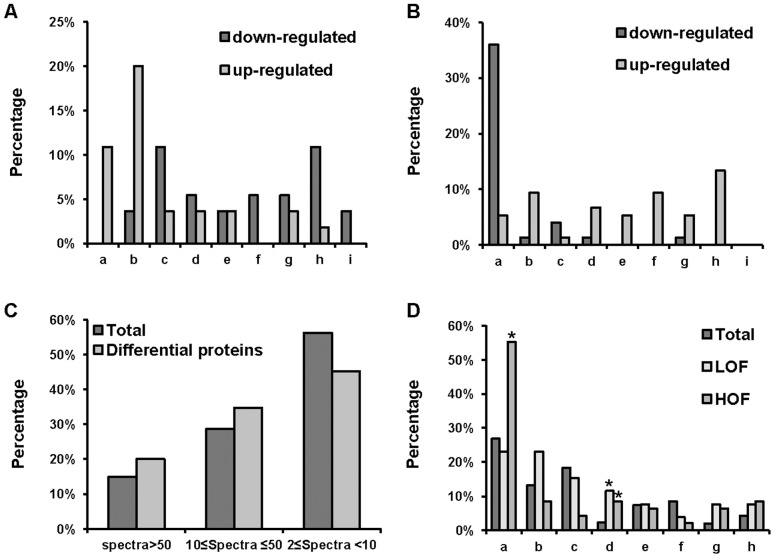
Functional category and protein abundance distribution analyses.(A and B) The distribution of proteins with differential expression in LOF or HOF across functional categories. The proteins were categorized in 9 groups as follows: a, Respiratory chain complex proteins; b, Membrane-associated proteins and transporters; c, Carbohydrate/lipid metabolism; d, calcium regulation-related; e, Peptide or amino acid synthesis/metabolism; f, Oxidation-sensitive; g, Chaperones; h, Translation-related; and i, Detoxification-related. Black bars: down-regulated proteins; gray bars: up-regulated proteins. (C) The abundance distributions of all mitochondrial proteins identified and the differentially expressed proteins. The protein abundance was categorized according to the total MS/MS spectra per protein and generally divided into three abundance groups (high: >50 spectra; medium: 10≤50 spectra; low: <10 spectra). The black bars represent the total mitochondrial proteins identified, and the gray bars indicate the proteins with differential expression in LOF or HOF. (D) The distribution of the abundant proteins across different protein functional categories. The abundant proteins were characterized as proteins with >10 total MS/MS spectra; the total mitochondrial proteins identified and the differentially expressed proteins in LOF and HOF were analyzed. The proteins were categorized in 9 groups as described above. The black, light-gray and dark-gray bars represent the total mitochondrial proteins, the differentially expressed proteins in LOF and HOF, respectively. The percentage of respiratory chain complex proteins in HOF was significantly larger (* p<0.05) than that of the control and LOF. The percentages of calcium-regulation-related proteins in LOF and HOF were both significantly larger (* p<0.05) than that of the control.